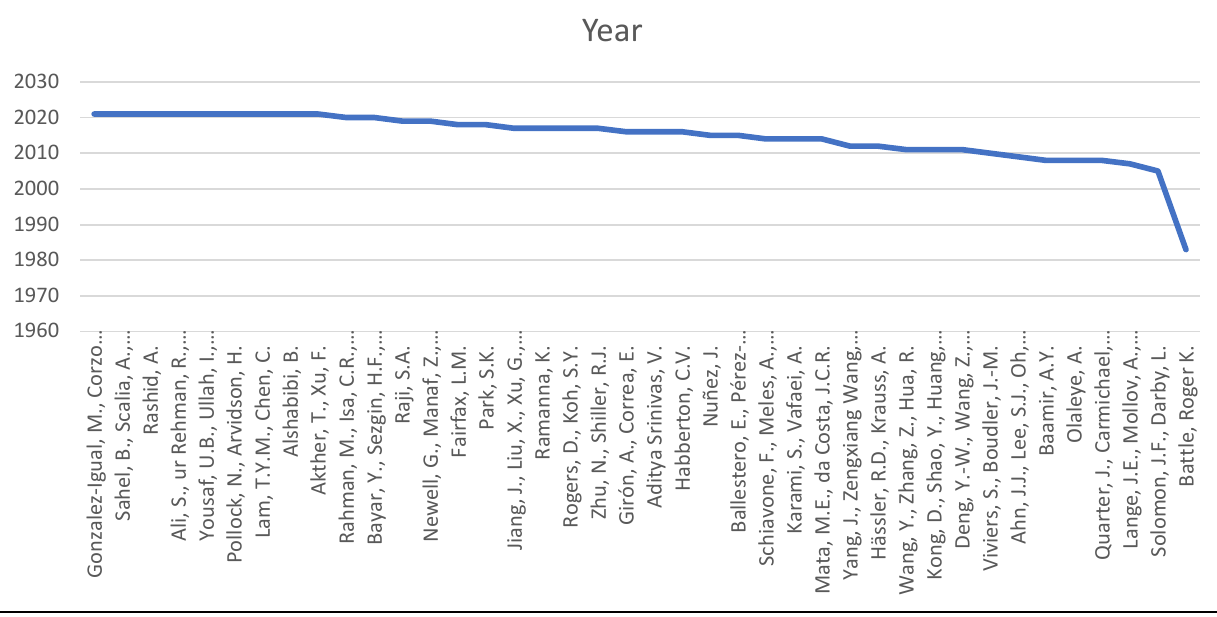
Figure 4. Lead Authors.